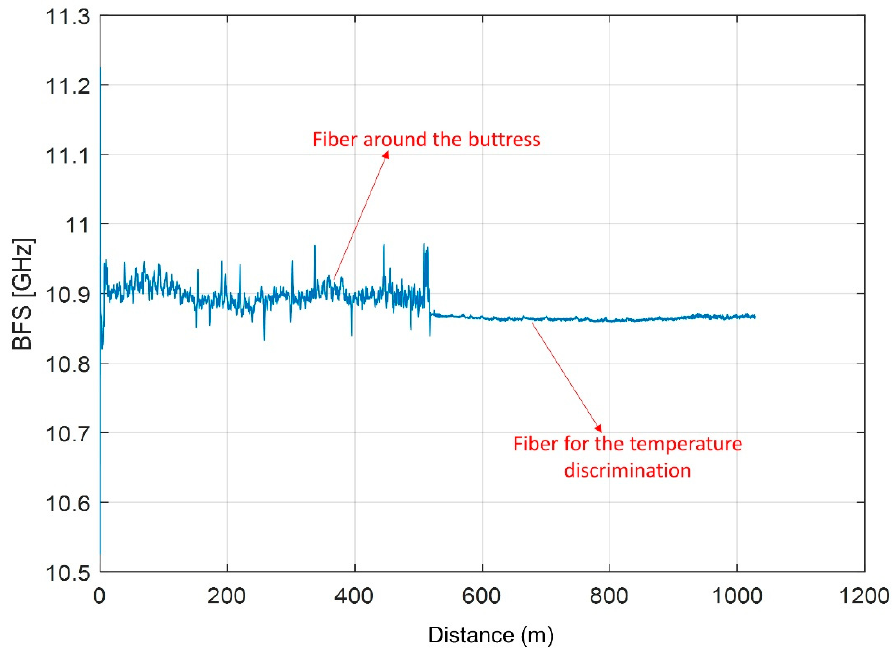
Figure 19. BFS profile acquired on January 4, 2018 (first measurement).